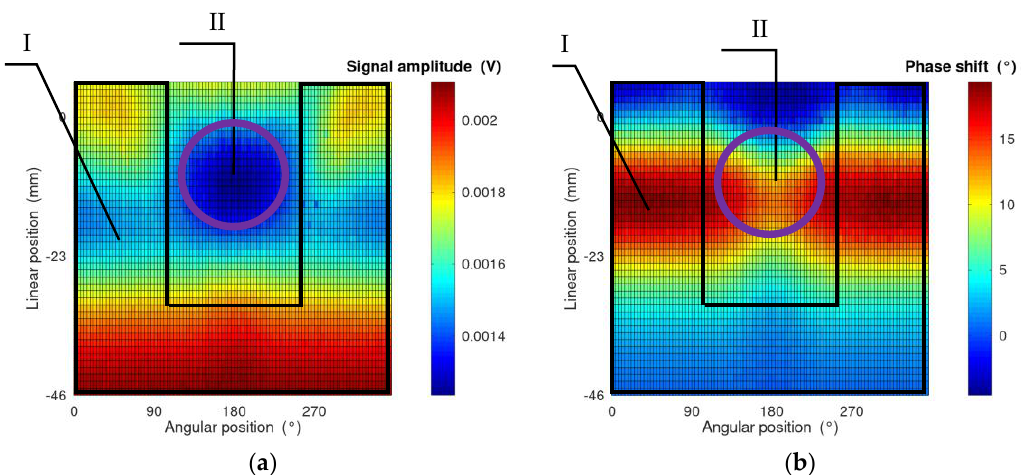
Figure 10. Exemplary results of forward tomography transformation for the sample with an 8 mm wide indentation. ( a ) Results of the signal amplitude as a function of the sample position; ( b ) results of the phase shift between the excitation and measured signals as a function of the sample position. Areas I and II represent projections containing information about sample radius and defect width, respectively.